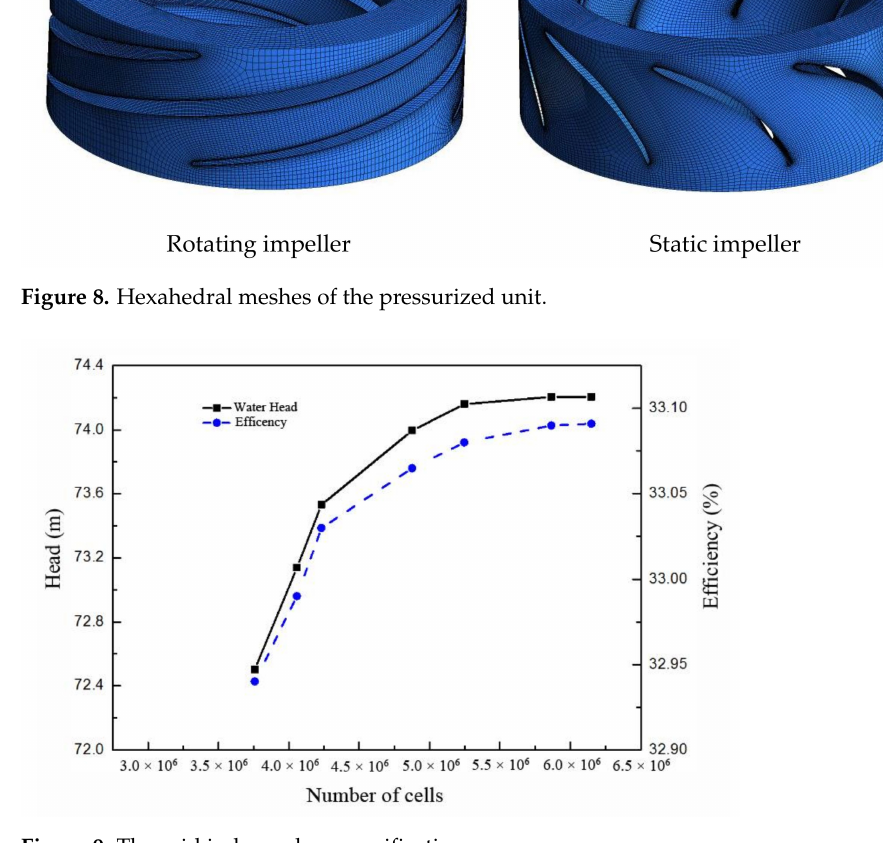
Figure 9. The grid independence